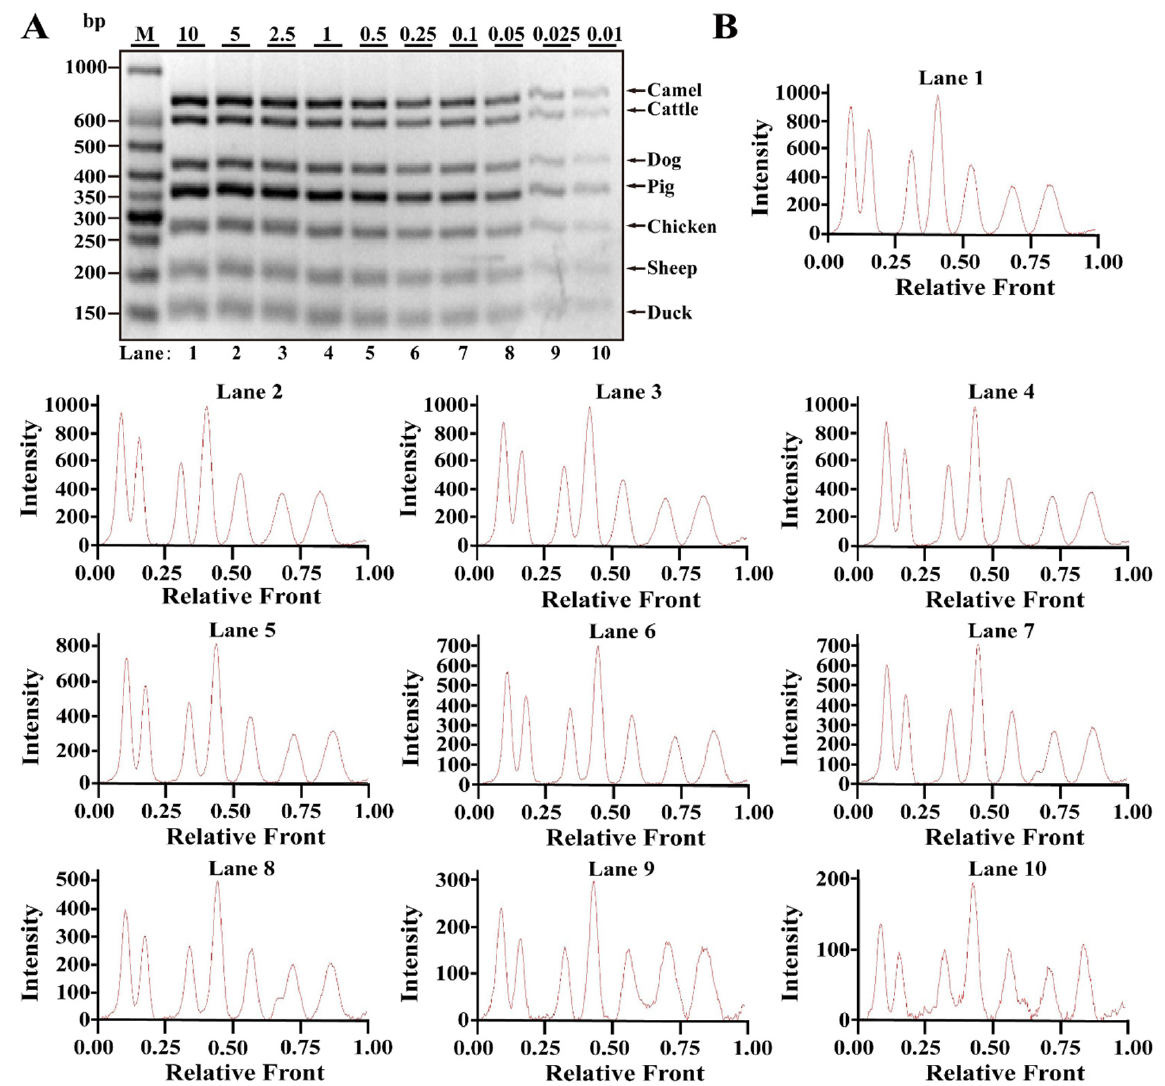
Figure 5. Validation of sensitivity of multiplex PCR assay in microwave-cooking meat tissues. ( A ) Gel image of PCR fragments amplified by multiplex PCR using premixed DNA contents of seven species (10, 5, 2.5, 1, 0.5, 0.25, 0.1, 0.05, 0.025 and 0.01 ng) with seven sets of target primers, respectively. ( B ) The corresponding electropherograms represent camel, cattle, dog, pig, chicken, sheep and duck in each lane. Lanes 1–10 are presented with labels (10, 5, 2.5, 1, 0.5, 0.25, 0.1, 0.05, 0.025 and 0.01) in ( A ). The value of number at the horizontal line means the relative position of peaks distant from the top of agarose gel. The value of number at the vertical line means the fluorescent intensity of DNA-bound dyes (4 S GelRed Nucleic Acid Stain). Lane M is ladder DNA.